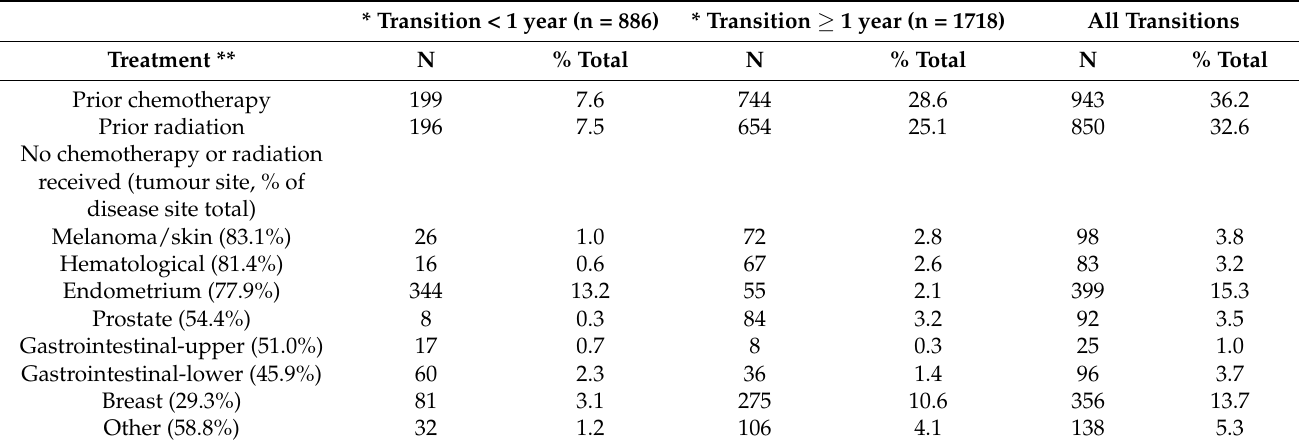
Table 2. Time to transition by treatment type, n =